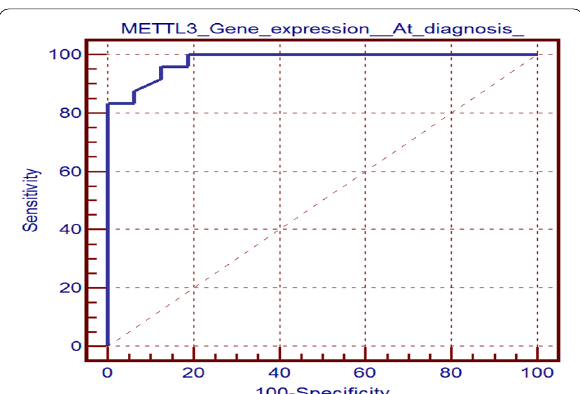
Fig. 2 Receiver operating characteristic (ROC) curve detect the best cutoff value of METTL3 gene expression level predicating response to